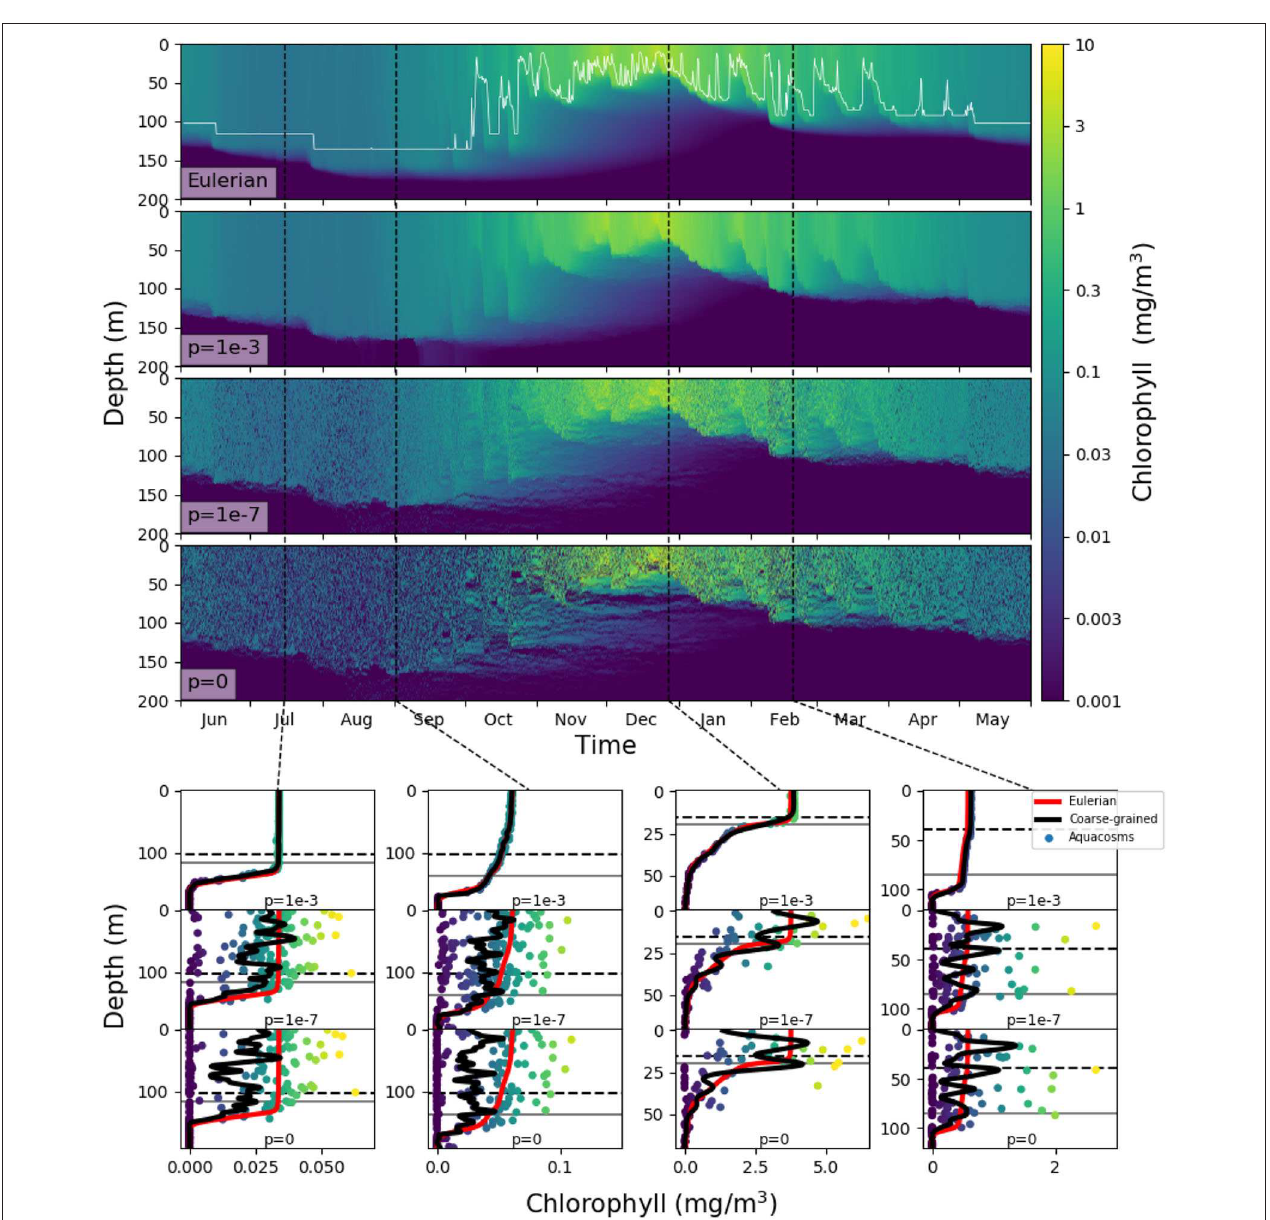
FIGURE 6 | Top four panels: chlorophyll in the SAZ simulation in logarithmic units. The top panel shows the eddy-diffusive Eulerian model, and the thin white line marks the mixed layer depth; the next three show the aquacosm simulations for p = 10 − 3 ,10 − 7 ,0. The lower panels show, as a function of depth, the chlorophyll content in mg/m 3 of the aquacosms (dots) for different values of p , their coarse-grained version (black line, see section 2), the mixed layer depth (horizontal gray line) and the turbocline depth (horizontal black dashed line) at the date marked in the upper panels by the vertical black dashed lines. For comparison, the chlorophyll concentration as a function of depth computed with the Eulerian simulation (red line) is repeated in all the panels corresponding to the same